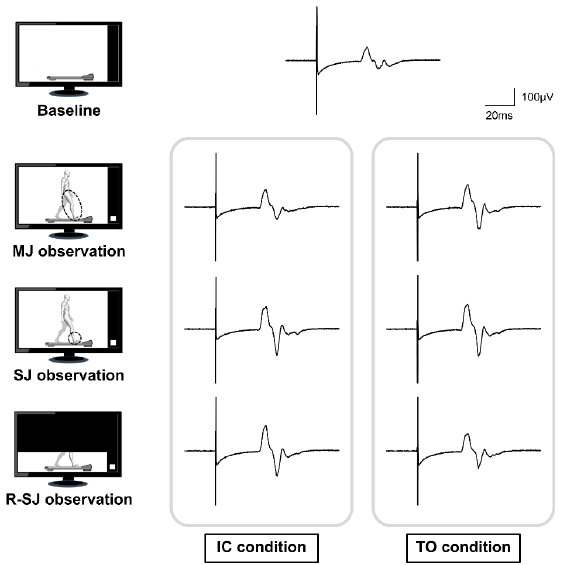
Figure 2. Representative waveforms of the averaged motor evoked potentials (MEPs) obtained from a single participant during the baseline, multiple-joint (MJ), single-joint (SJ), and restricted single-joint (R-SJ) observation conditions. The four pictures on the left represent the simplified observation conditions. The MEP on top of the image is the averaged waveform recorded at baseline condition; below, the MEPs presented were recorded at the initial contact (IC) and toe-off (TO) conditions.